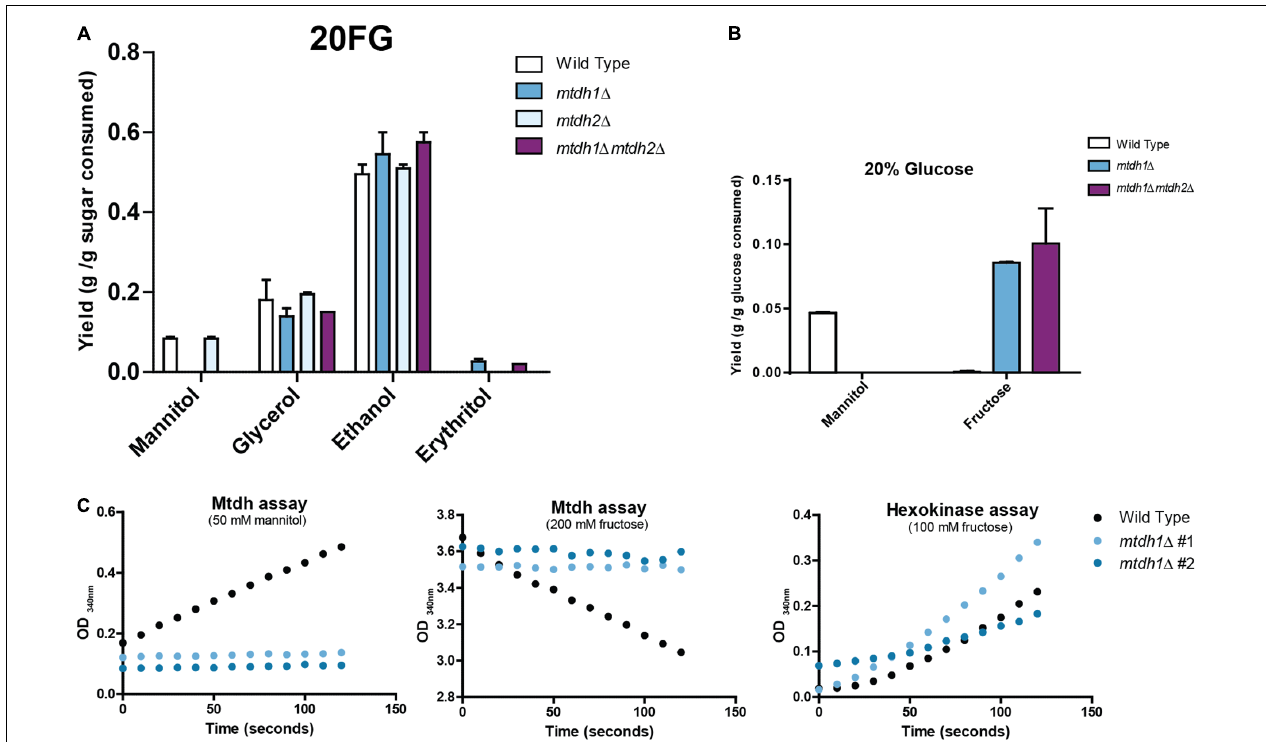
FIGURE 2 | Metabolite production and mannitol dehydrogenase (Mtdh) activities in St. bombicola wild type and deletion mutants. (A) Metabolite production in St. bombicola wild type and deletion mutants ( mtdh1 (cid:49) , mtdh2 (cid:49) , mtdh1 (cid:49) mtdh2 (cid:49) ) cultivated in YP supplemented with 10% (w/v) glucose and 10% (w/v) fructose (20FG) at 30 ◦ C for 76 h. (B) Mannitol and fructose production in St. bombicola wild type, mtdh1 (cid:49) , mtdh1 (cid:49) mtdh2 (cid:49) cultivated in YP medium supplemented with 20% (w/v) glucose at 30 ◦ C for 76 h. (C) Mtdh activities in cell-free extracts of wild type St. bombicola (black dotted line) and mtdh1 (cid:49) (blue lines represent